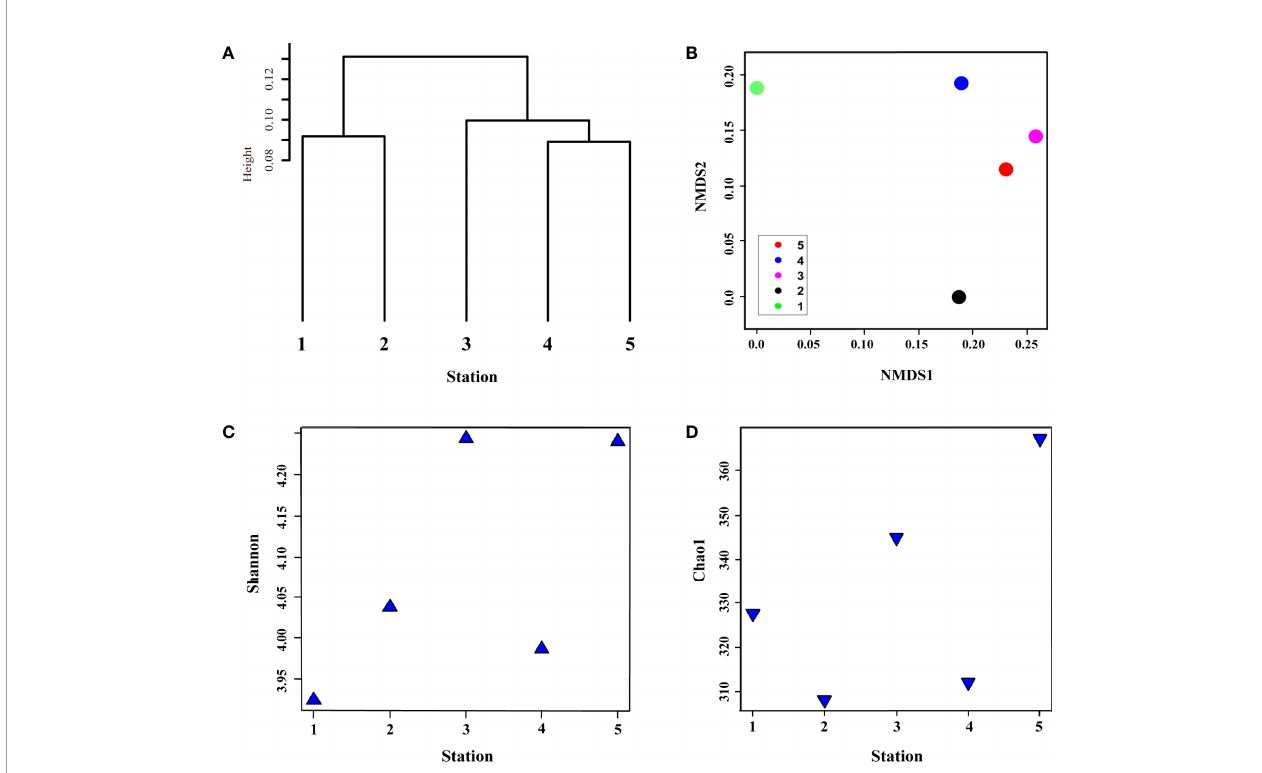
FIGURE 6 | Surface bacterial community composition similarity and difference in abundance and diversity during winter. (A) clustering of samples at the operational taxonomic unit (OTU) level based on Bray – Curtis distance; (B) dissimilarity of bacterial community composition using unweighted-unifrac method, the alpha diversity of surface bacterial community; (C) diversity and (D) species richness using Shannon and Chao1 indices,